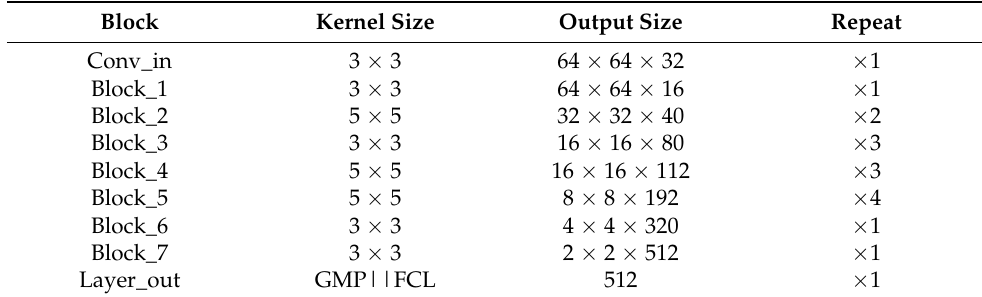
Table 1. Encoder in channel expansion VAE.